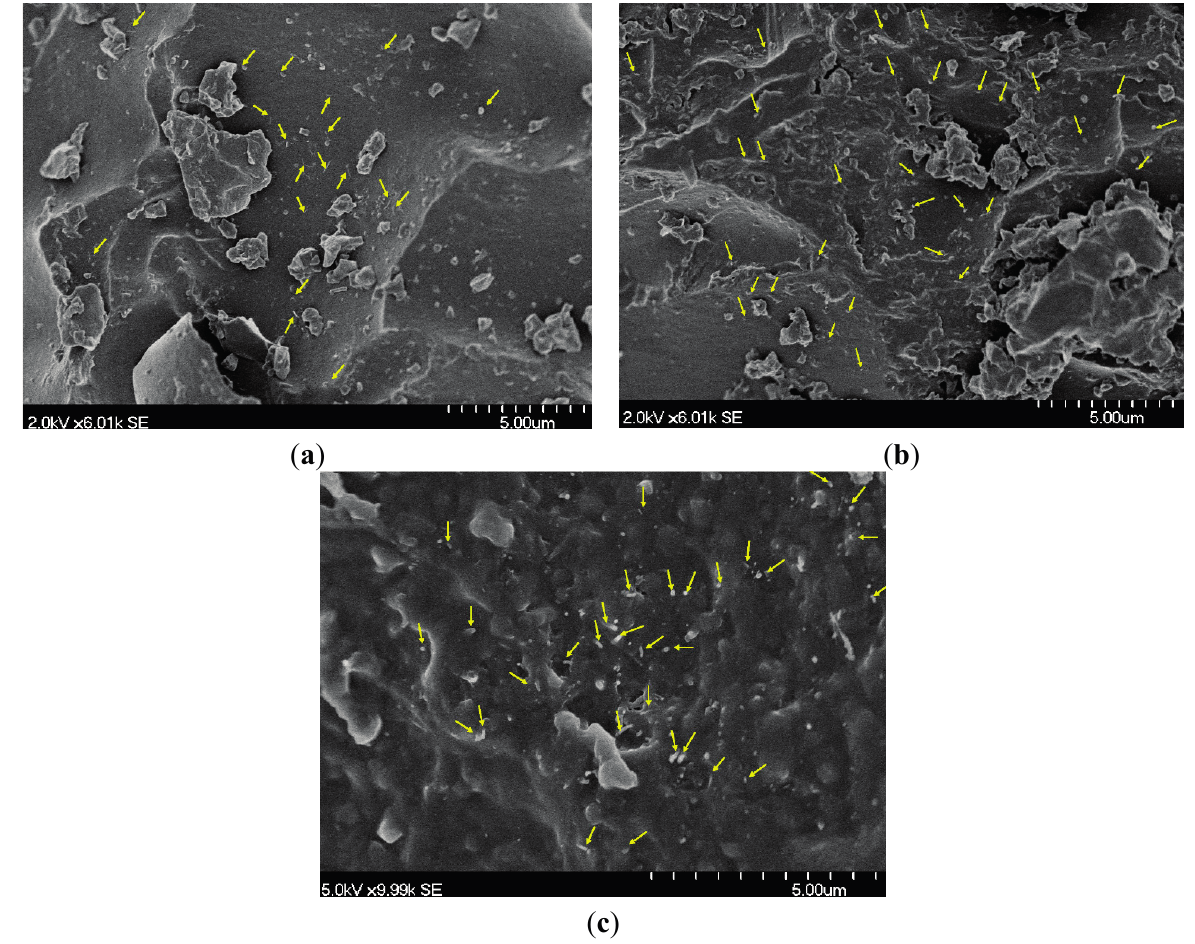
Figure 13. SEM images for specimens containing ( a ) 0.5 wt%, ( b ) 1.0 wt%, and ( c ) 1.5 wt% MWCNTs showing the dispersion of MWCNTs in the epoxy